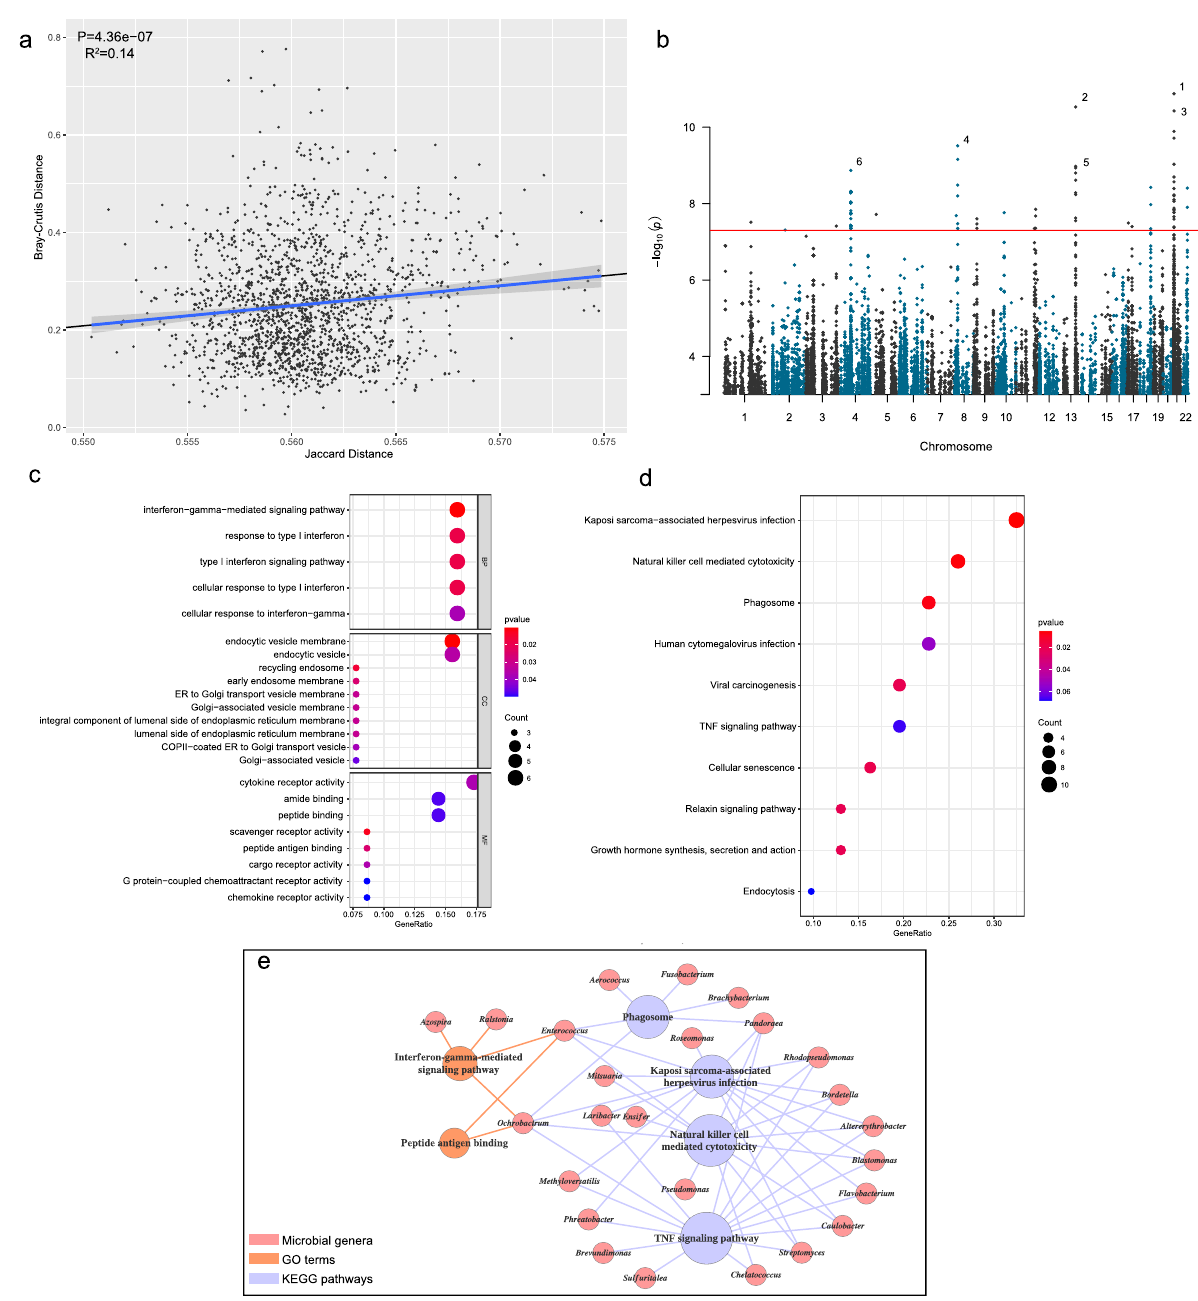
Fig. 6 Host genetic variation can in fl uence the composition of the tumor microbiome. a Genetic dissimilarity de fi ned by Jaccard distance between patients is correlated with microbial beta-diversity (Bray – Curtis metric distance). Linear regression was used to evaluate the signi fi cance and coef fi cient of determination. The 95% con fi dence interval is shown. b Manhattan plot illustrating QTLs for microbial genus abundance. Each dot denotes an association pair between genetic variation and a microbial genus. The number labeled beside denotes the signi fi cance rank of QTLs. The red line corresponds to a signi fi cance threshold of 5 × 10 − 8 (FDR < 0.01) c Gene ontology enrichment for genes identi fi ed from loci associated with the abundance of genera. d KEGG pathway enrichment for genes identi fi ed from loci associated with the abundance of genera. The color and size of each bubble denote enrichment signi fi cance and the number of genes enriched in the functional category, respectively. e Correlation network showing the association between selected enriched GO terms or KEGG pathways and microbial genera. The functional terms were manually classi fi ed into 3 types. Lines denote the association, and colors represent the types of